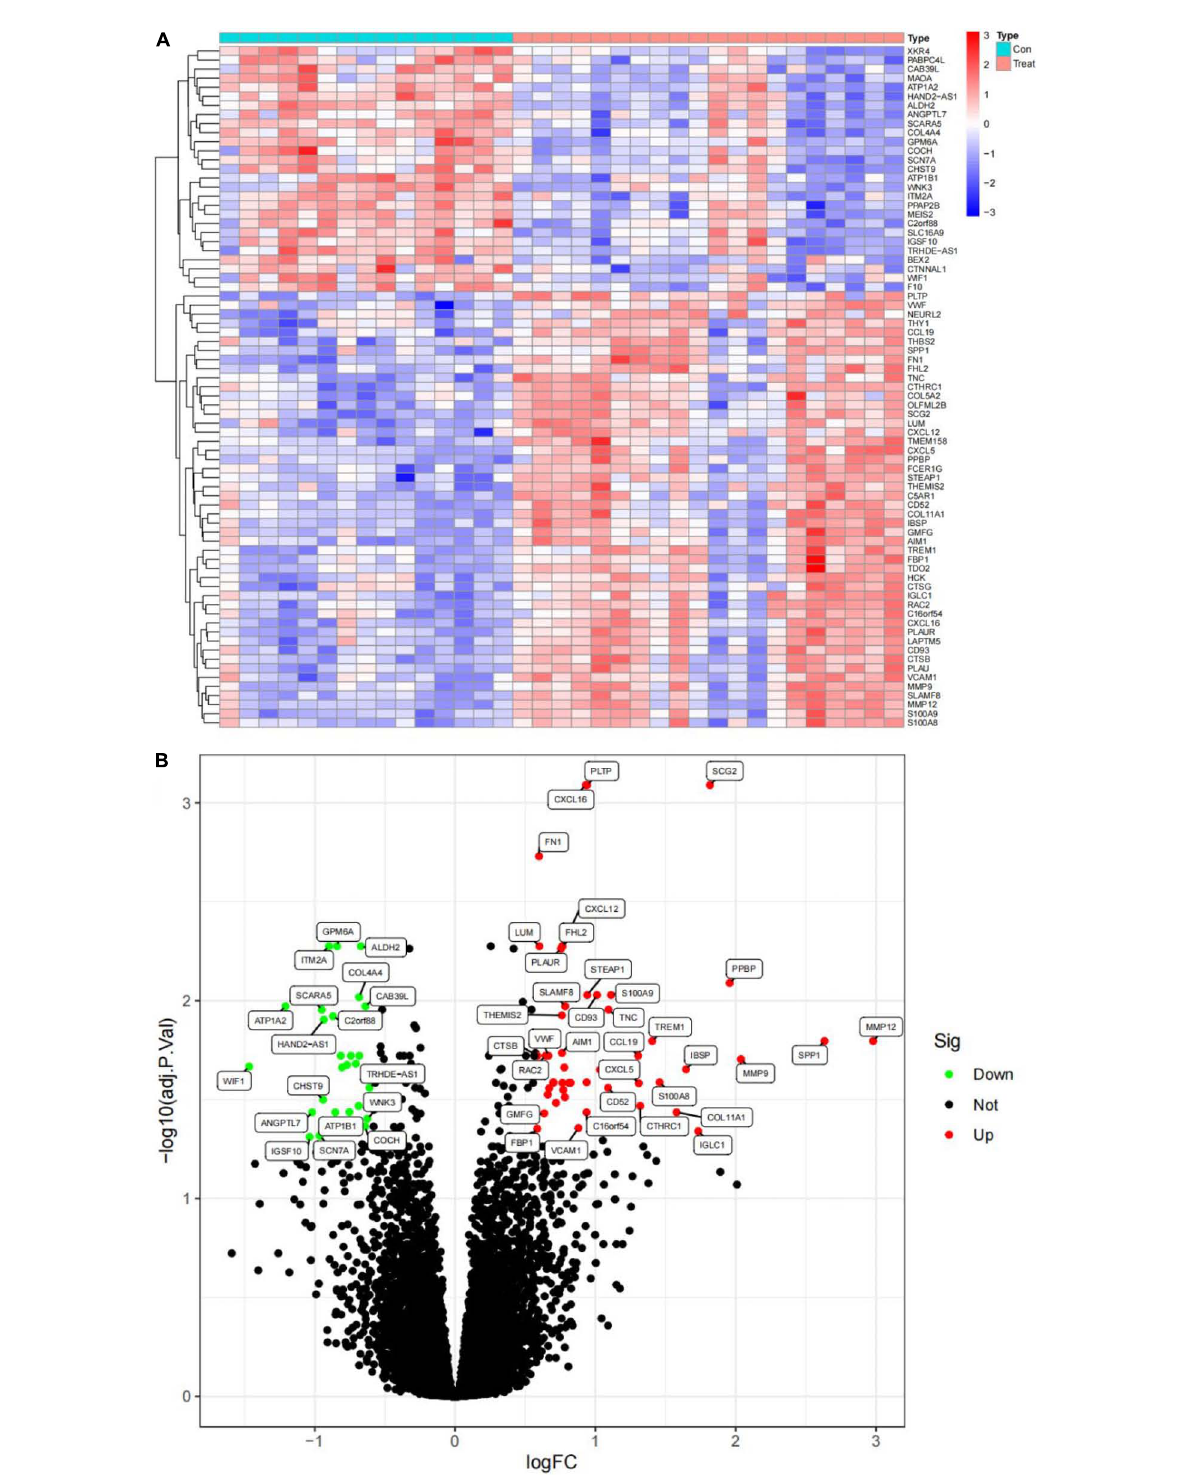
FIGURE2 Visualization of differential analysis. (A) Heat maps of DEGs in AVC and normal samples. Red represents AVC samples, and blue represents normal samples. Blue indicates that the relative gene expression level is low, while red indicates that the relative gene expression level is high. (B) The volcano map illustrates the distribution of DEGs in the combined data set. Red indicates a high level of DEGs expression, and green indicates a low level of DEGs